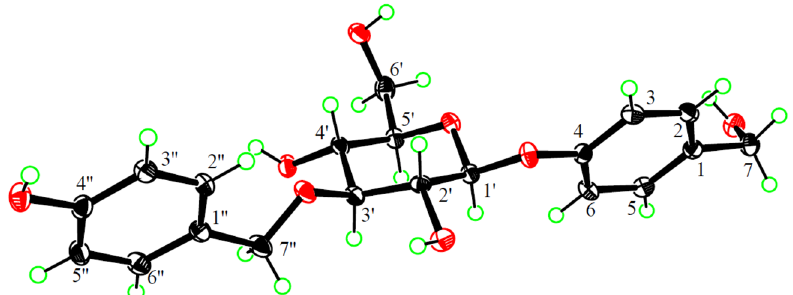
Fig. 3 ORTEP diagram of crystal structure of